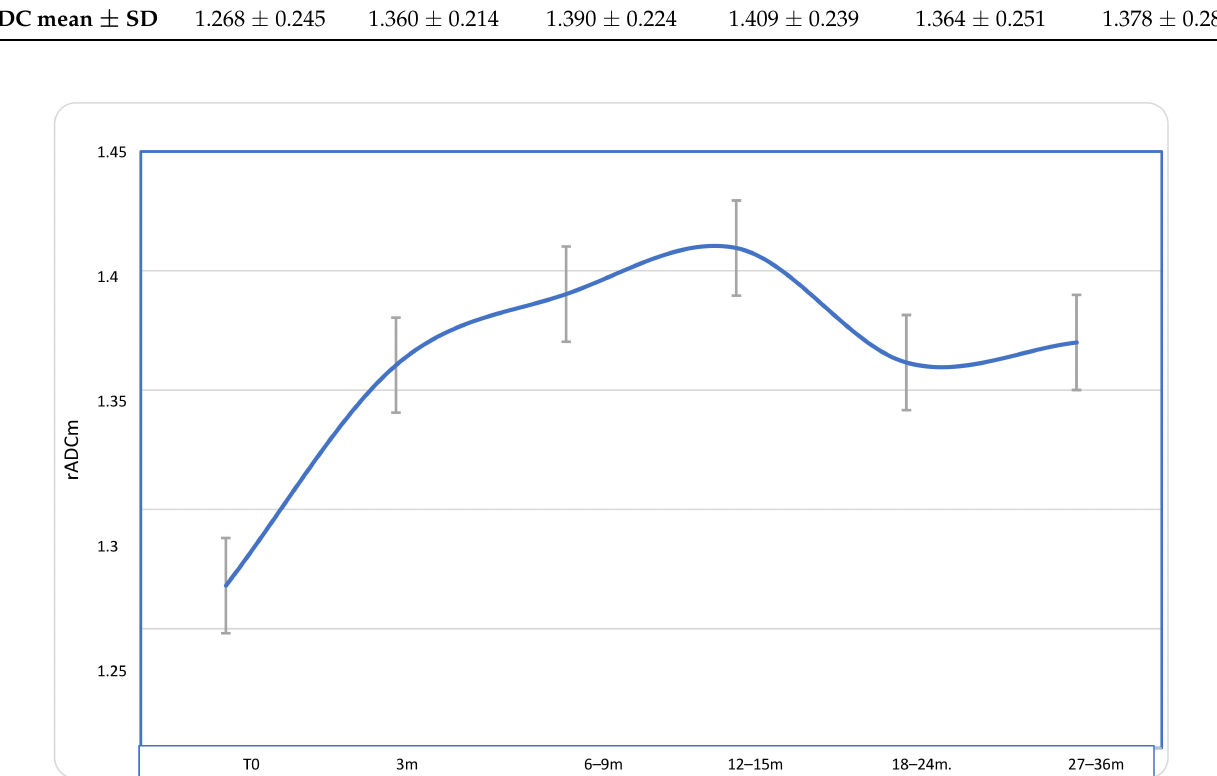
Figure 2. Longitudinal course of rADCm values in patients with MN during a follow-up of 27–36 months after proton- therapy treatment. A significant progressive increase of rADCm values was detected at each time point if compared to baseline, with a peak at 12–15 months; the values then slightly decrease but remain significantly higher than those at